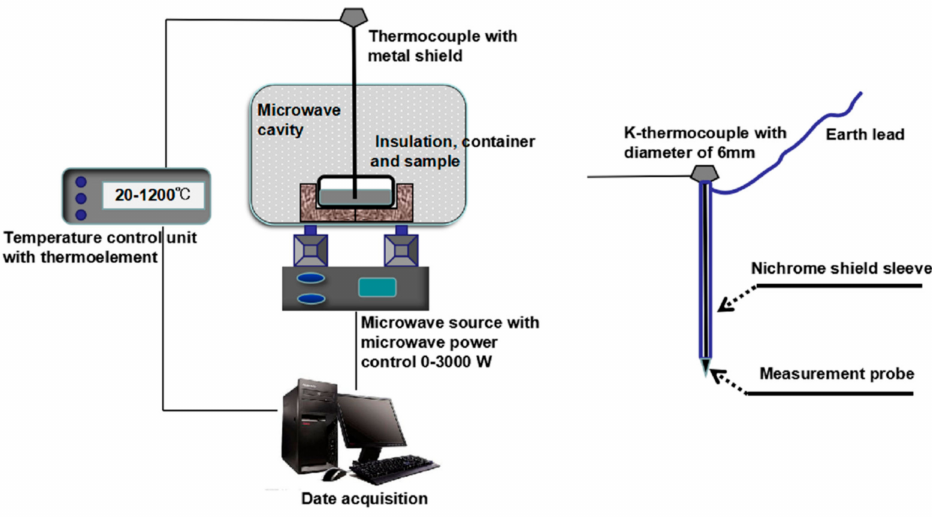
Figure 3. Schematic of the microwave roasting